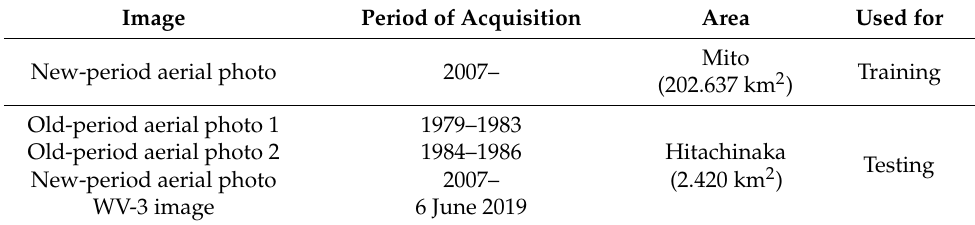
Table 1. Remote sensing images used for training and testing. Image Period of Acquisition Area Used